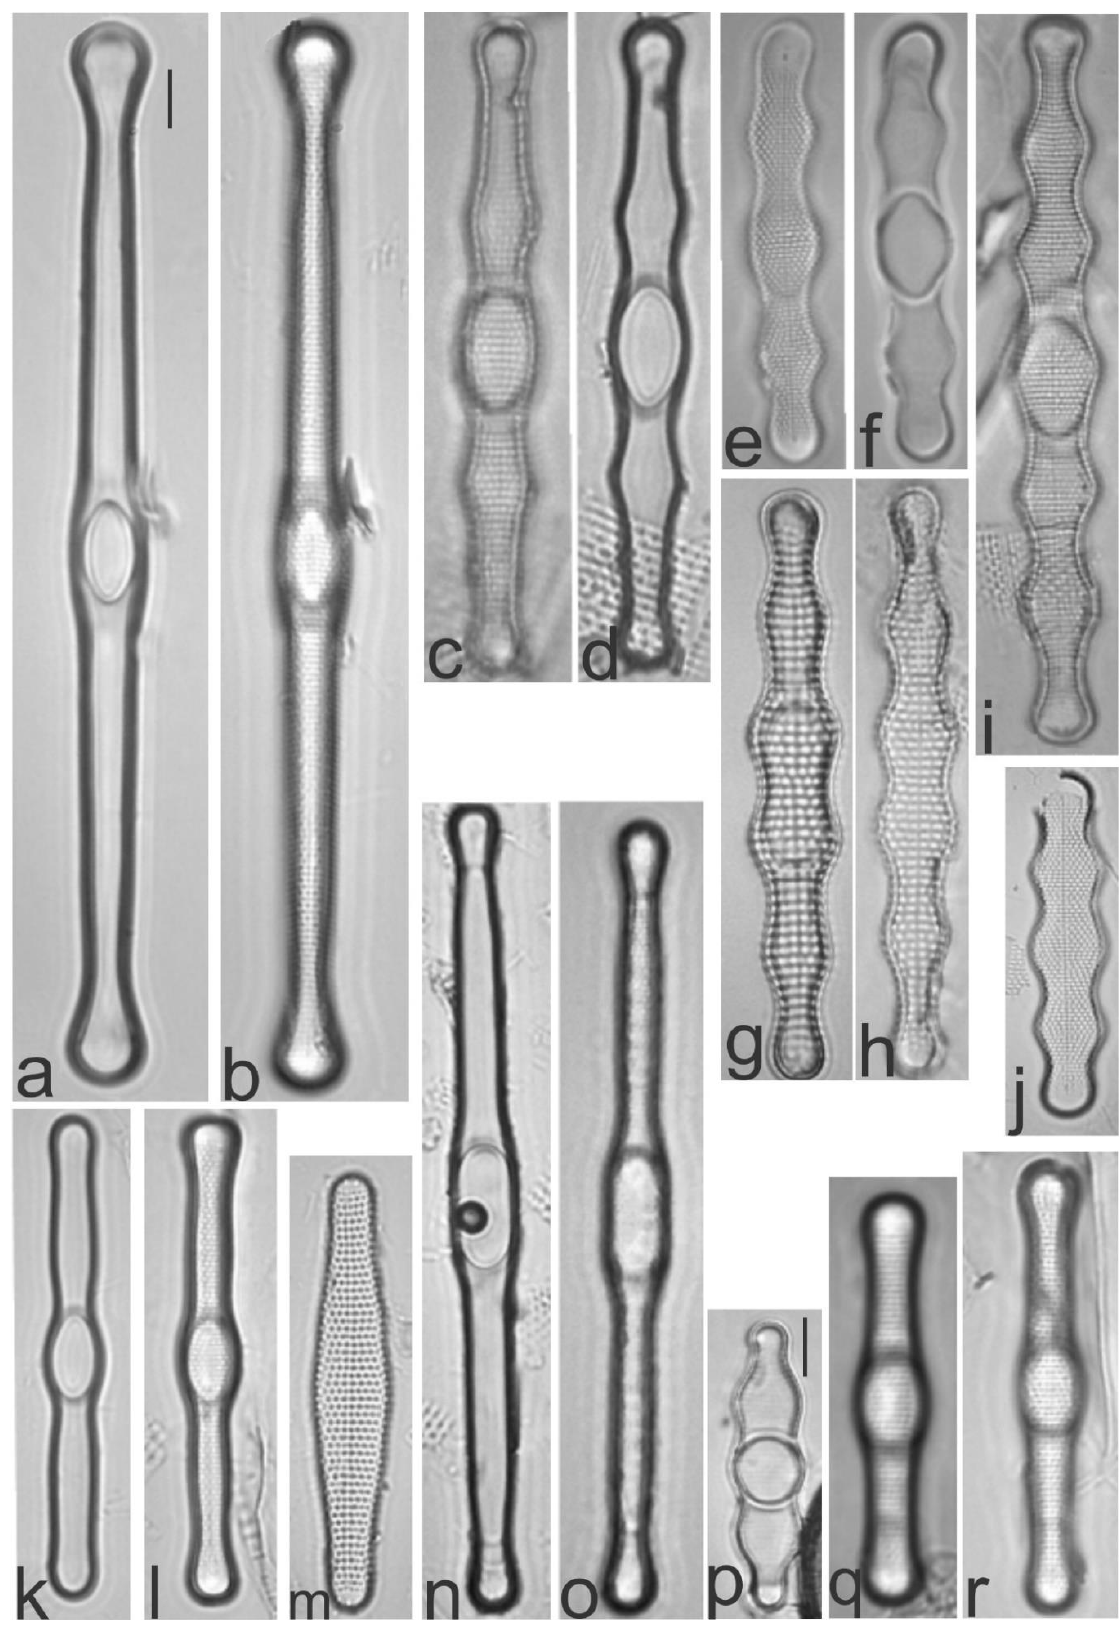
Figure 10. ( a , b , q , r ) Grammatophora monilifera ; ( c – f ) G. undulata ; ( g , h ) G. undulata var. gallopagensis ; ( i , j ) G. undulata var. gibba ; ( k , l ) G . merletta ; ( m ) G. marina var. subundulata ; ( n , o ) G. caribaensis ; ( p ) G. ovalauensis . Scale bar: ( p ) = 7.5 μm; all others = 5 μm